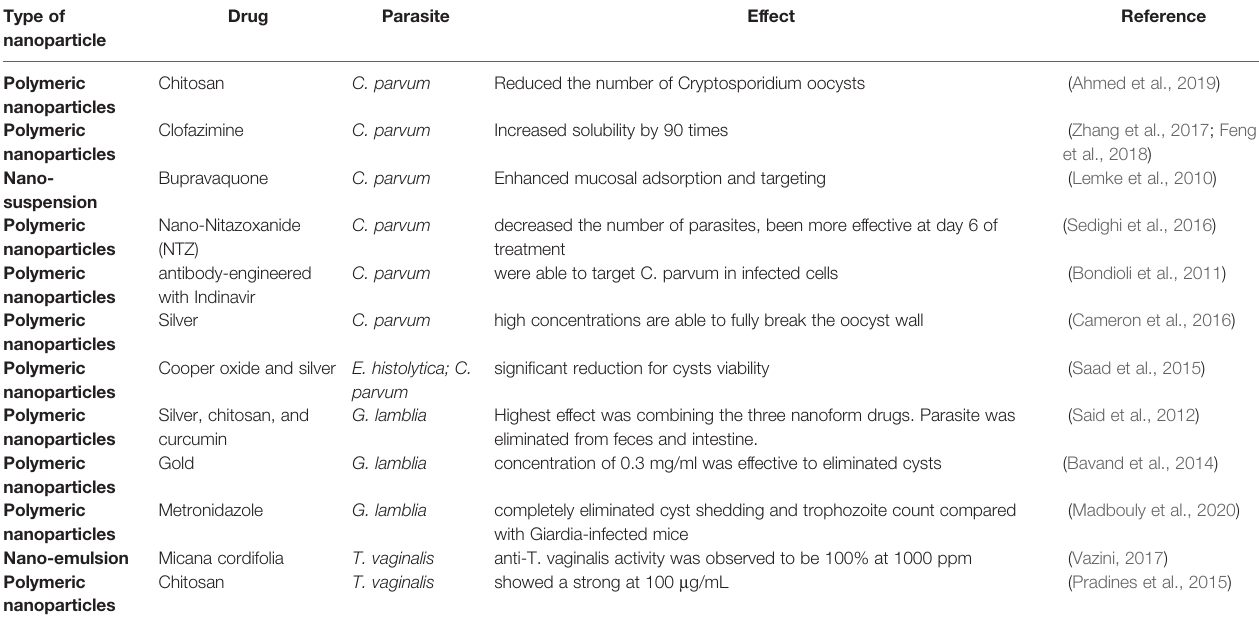
TABLE 2 | List of the types of nanoparticles susceptibility to protozoa